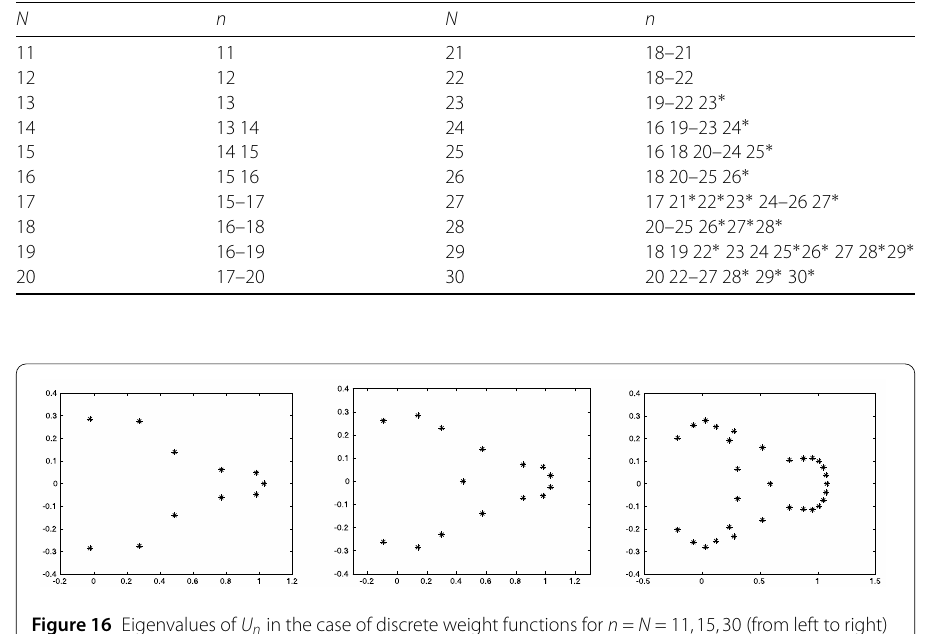
avoid these pitfalls, we overwrite the zero, once computed, by N /2 or reset (cid:14) x j (cid:15) , j = 1, n , by 0 resp. N –